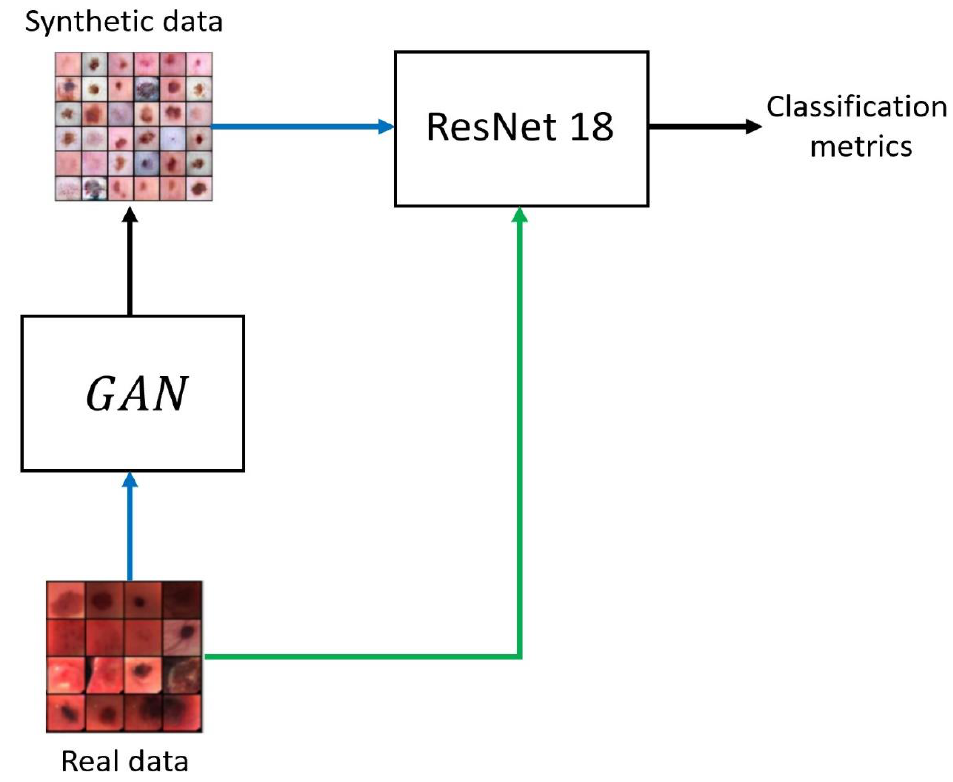
Figure 6. The proposed methodology to evaluate the similarity of the datasets. The blue arrows indicate that a set was used to train a model. The green arrow indicates that the set is classified by the